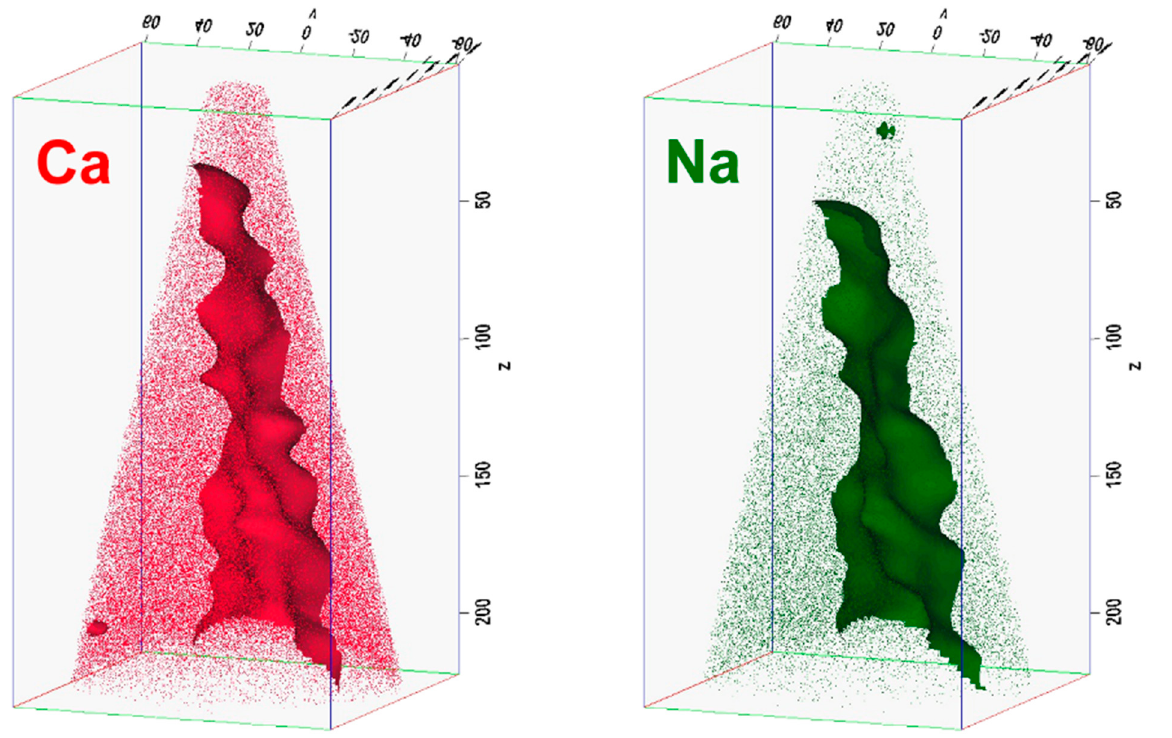
Figure 6. Ca and Na atom maps (30% displayed) from the reconstruction of the atom probe tomography data (scales in nm). No obvious change in concentration can be directly observed in the reconstruction. The isosurfaces of Ca and Na concentrations are shown in the figure as a representation of the lamellar boundary. The concentrations of Ca and Na had to be seriously smoothed with large delocalization factors; otherwise, the local fluctuation in concentrations (most likely due to the density modulation in the crystal structure) would overwhelm the difference across the lamellar boundary. The boundaries in the Ca and Na maps are very similar in detail and show similar roughness as the high-resolution TEM images in Figure 1. A movie file (gif file) showing the 3D rotations of the maps can be found in Supplementary Materials (Video